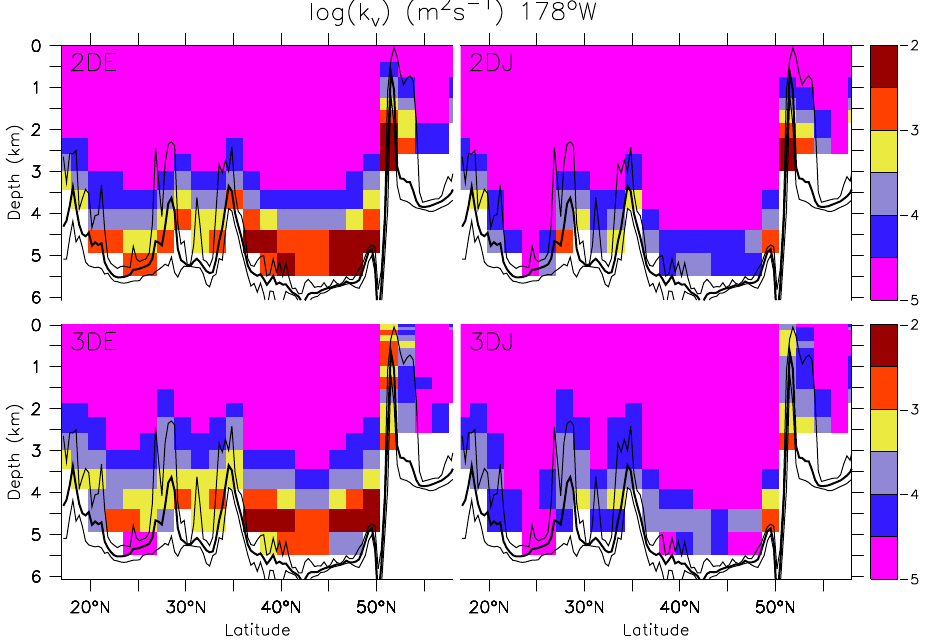
Fig. 4. Effect of the subgrid-scale parameterization on vertical diffusivities along 178 ◦ W in the North Pacific. The northern part of the section corresponds to the one shown in Fig. 3. All experiments were initialized from observations for temperature and salinity and integrated for 10d, which leads to almost identical N 2 .